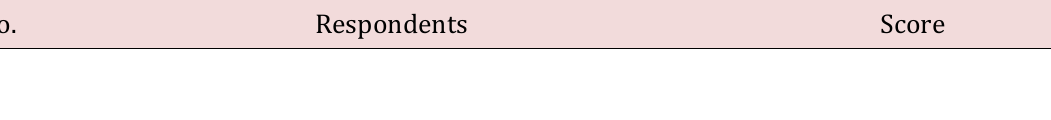
Table 6. Score of the students' reading in cycle